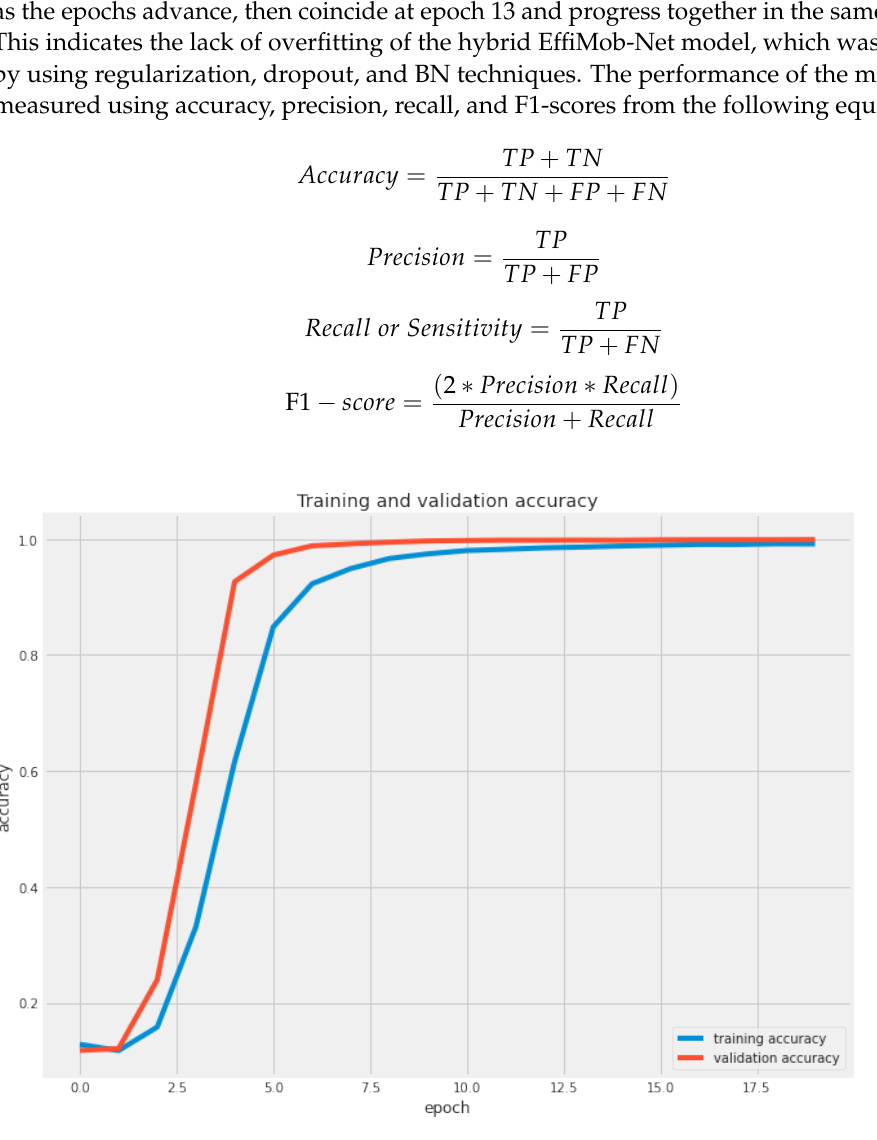
Figure 7. Training and validation accuracy.